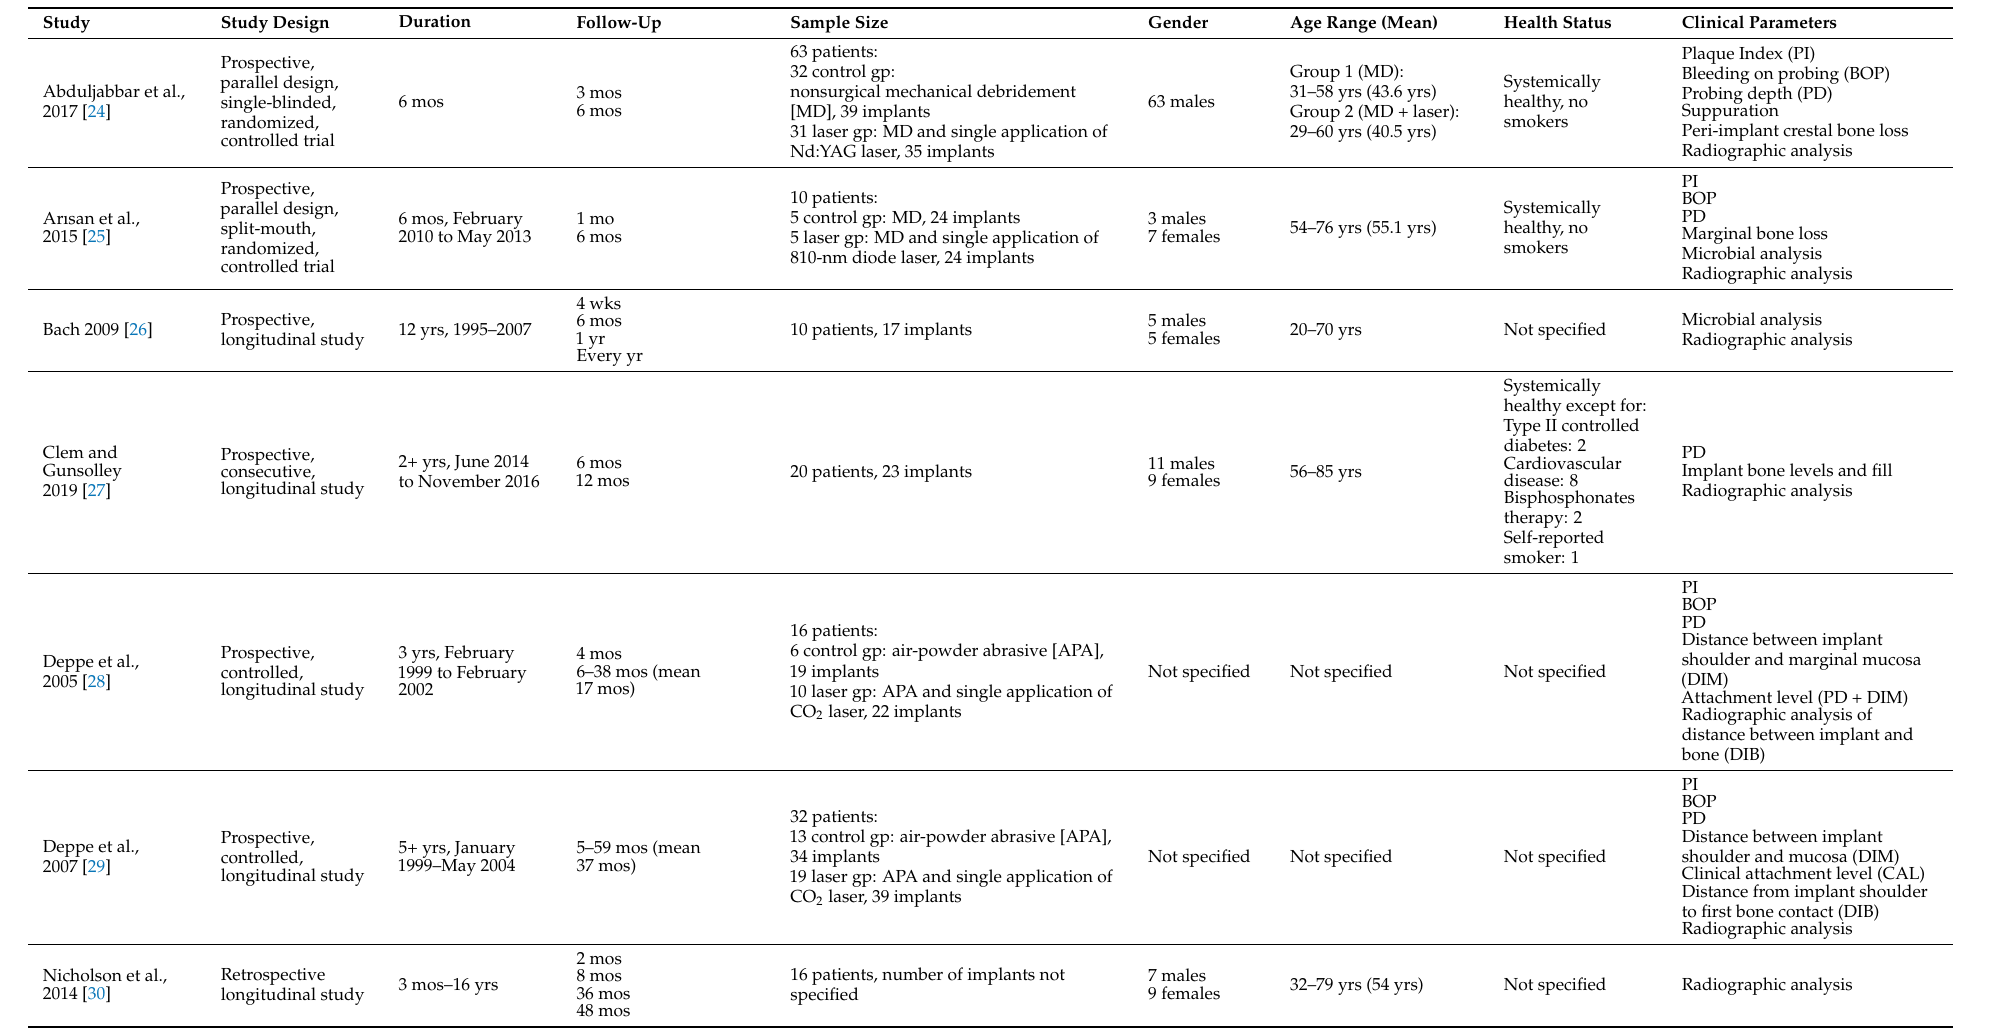
Table 2. Study design and